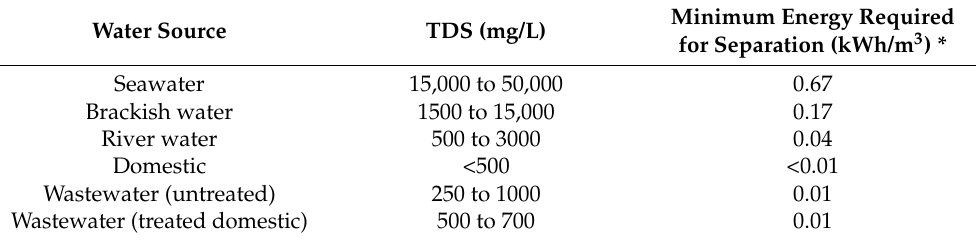
Table 1. Different water resources for desalination, the ranges of Total Dissolved Solids (TDS), and the minimum energy for separation (adapted from [88]).